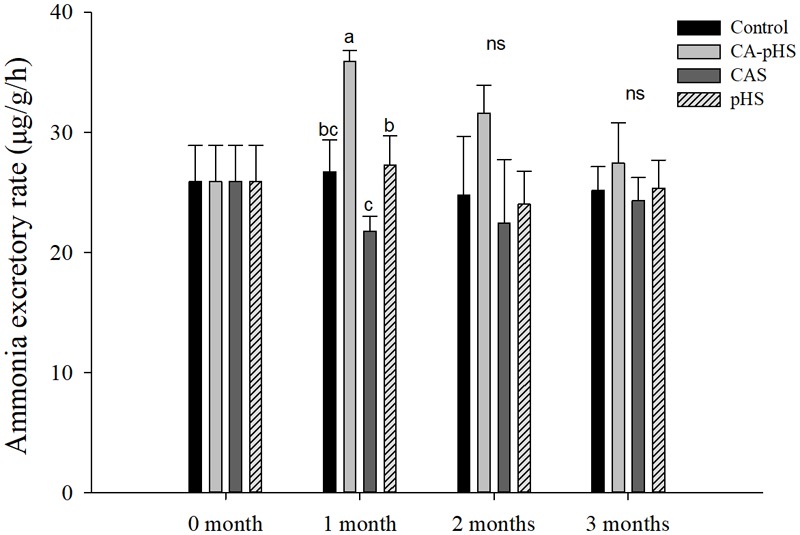
Juvenile of S. constricta ammonia excretory rate in the long-term toxicity test. Bars (mean ± SE, n = 3) with different letters denote significant differences (p < 0.05) among the four groups in each month. The letters “ns” indicate insignificant difference among the four groups in each month.